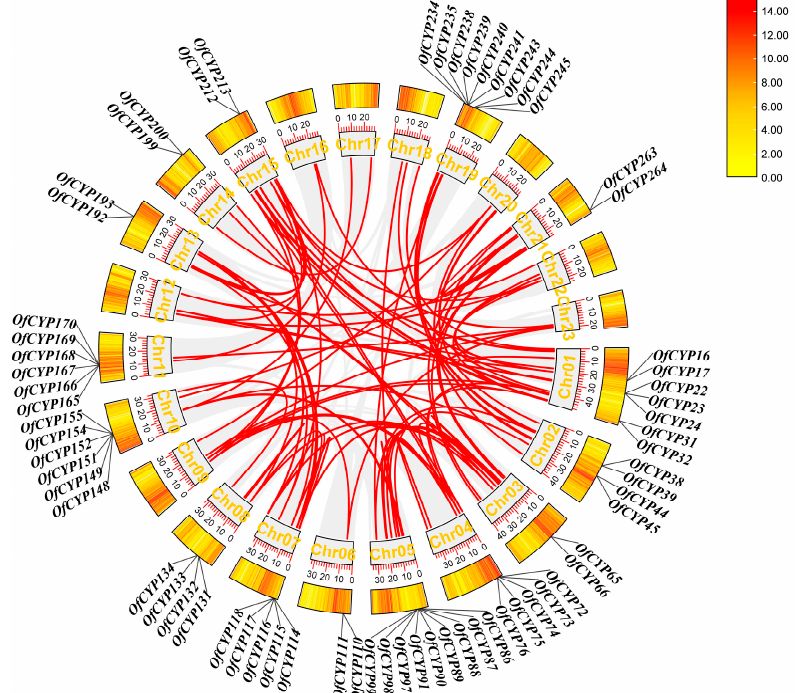
Figure 3. The gray lines in the background represent all syntenic blocks while the marked red lines represent 66 segmental duplication pairs of OfCYP s in the sweet osmanthus genome. The genes marked in the outermost layer of the circle are 67 tandem duplicated genes. The numbers on the tick marks above the chromosome names indicate the number of CYP genes contained on each chromosome. The density of genes on each chromosome is represented by the heatmap in the orange rectangle.